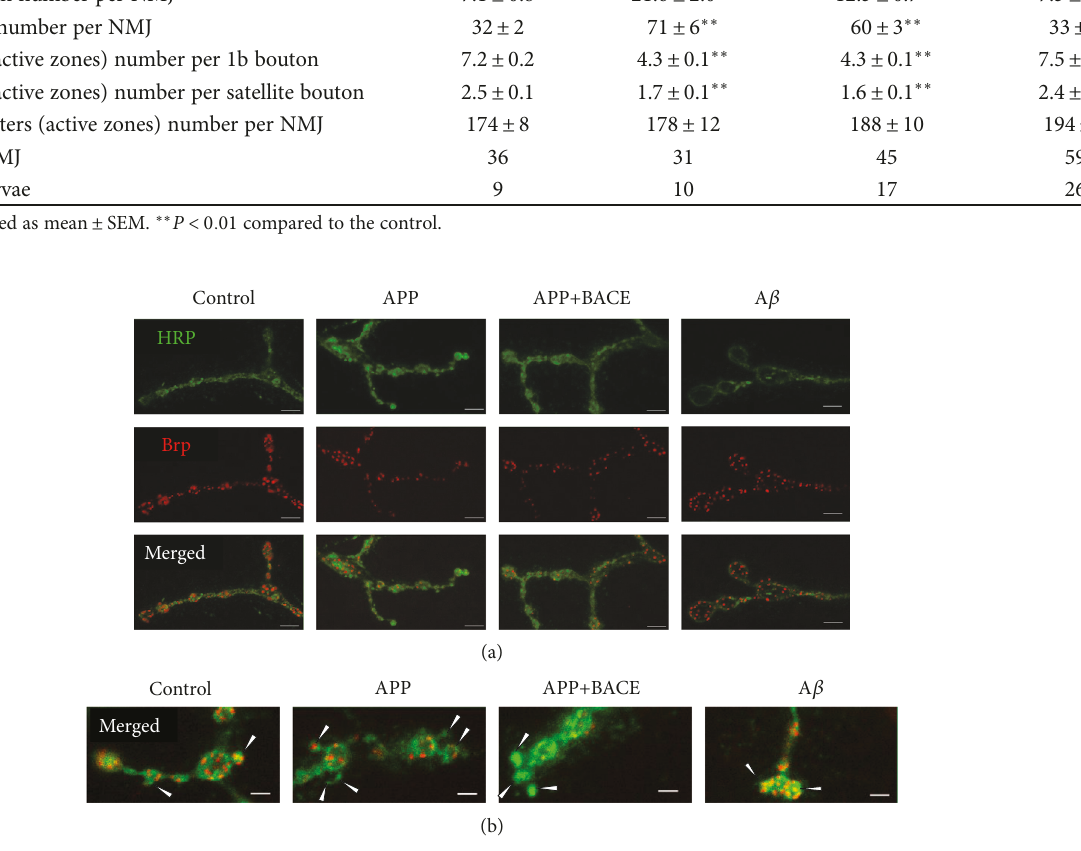
Figure 1: Muscle 4 neuromuscular junction. Bruchpilot and corresponding active zone distribution in synaptic boutons from transgenic Drosophila melanogaster larvae. (a) 1b boutons. (b) Satellite boutons (identi fi ed by arrowheads). Representative confocal images from the control, APP, APP+BACE, and А β lines are shown. Muscle 4 neuromuscular junctions were costained with antibodies against HRP (green channel) and the presynaptic AZ protein Brp (red channel). Scale bars, 5 μ m (a) and 2 μ m